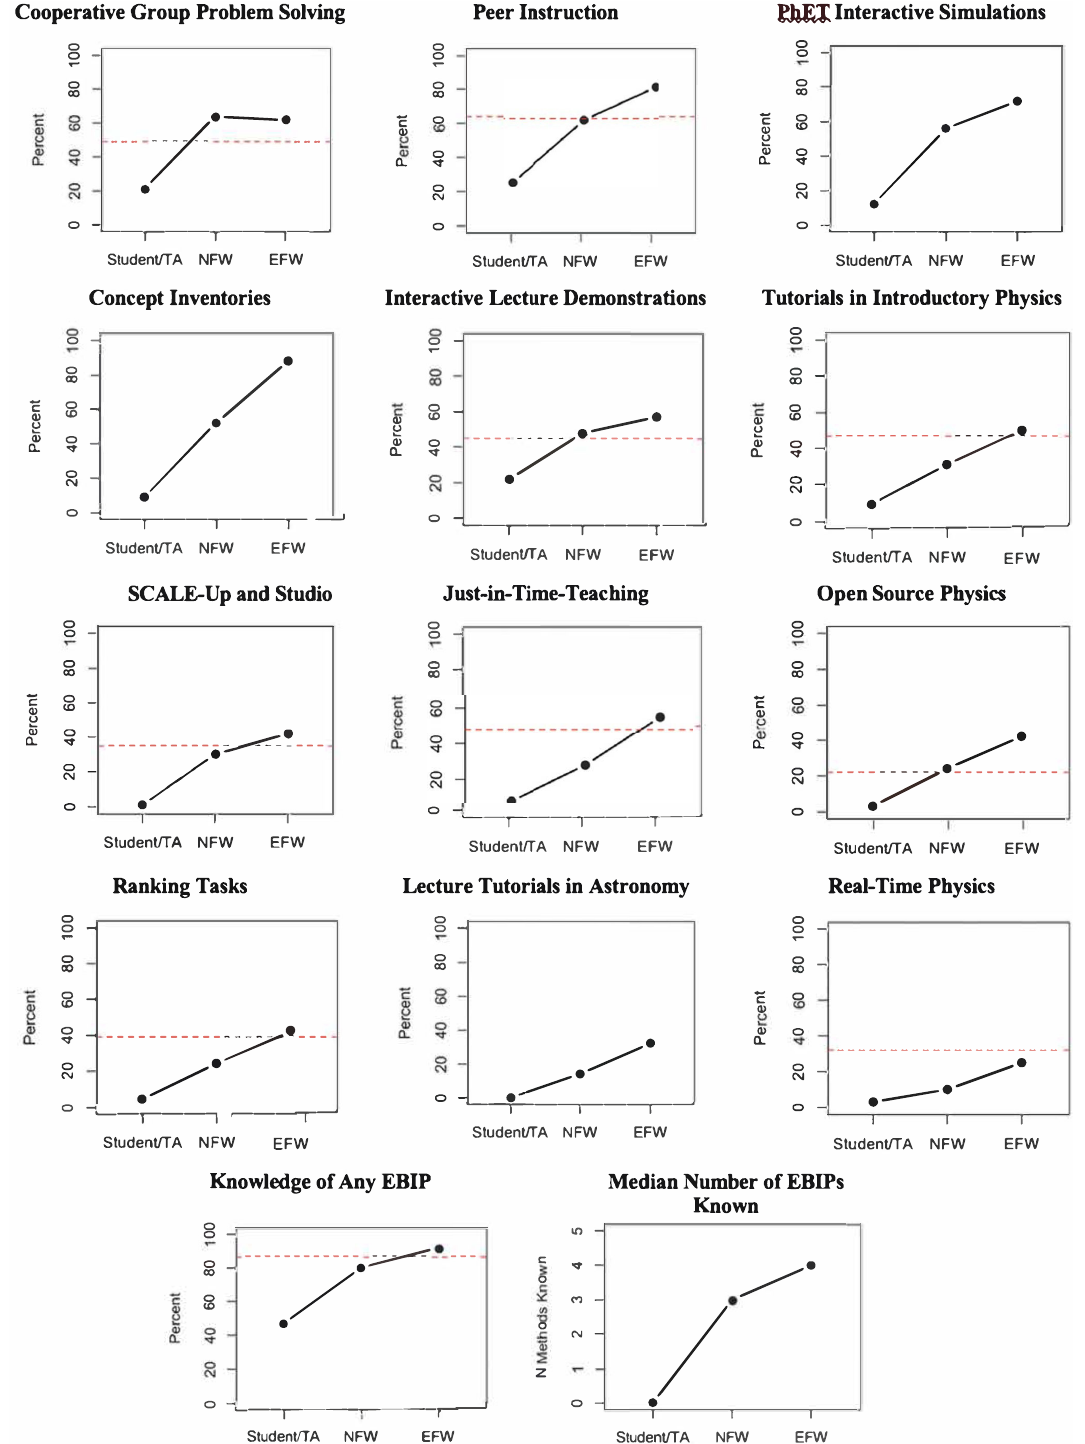
FIG. 4. Level of familiarity with specific EBIPs by teaching experience. “ Familiarity ” includes respondents who answered selected any of the following choices: I am familiar with it but have never used it, I have used all or part of it in the past, or I currently use all or part of it. Respondents are shown in order of increasing teaching experience: (1) Student or TA ( n ¼ 116 ), 0 average years of teaching experience, data from June 2015 and June 2018 NFW cohorts; (2) New faculty ( n ¼ 442 ), 2.5 average years of teaching experience, data from NFW presurvey; (3) Experienced faculty ( n ¼ 40 ), 18 average years of teaching experience, data from EFW presurvey. The dotted line shows the comparison to historical data (N ¼ 722 ), 15.4 average years of teaching experience (Henderson and Dancy [1]; Tables VI and